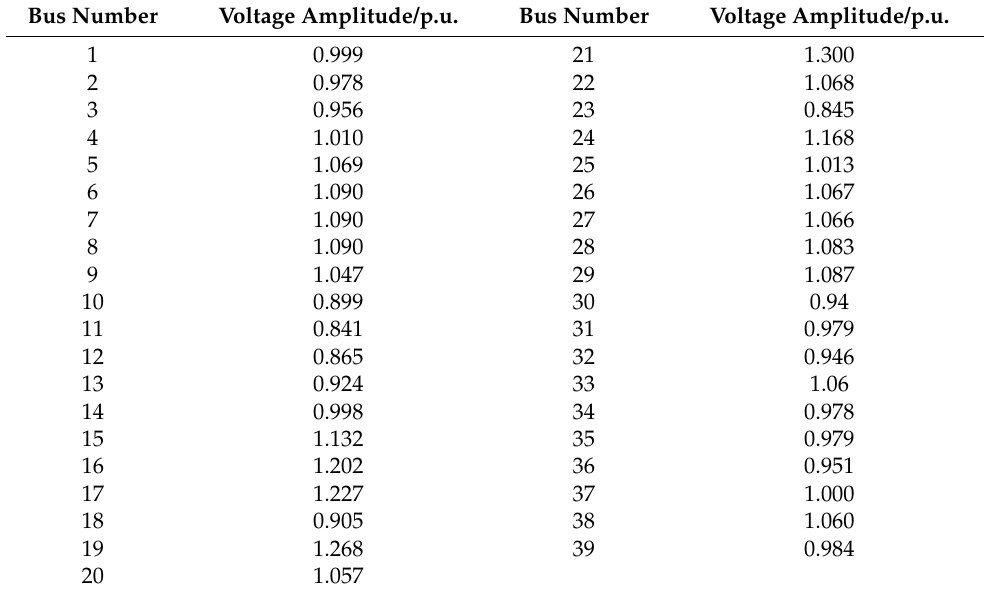
Table 3. The voltage of each bus in the initial state before optimization. Bus Number Voltage Amplitude/p.u. Bus Number Voltage Amplitude/p.u.